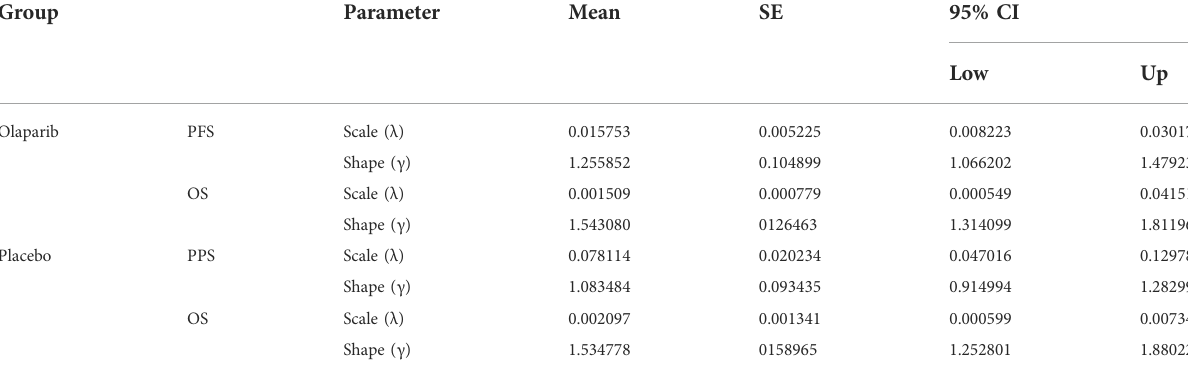
TABLE 1 Weibull parameters of the model estimated for progression-free and overall survival curves.